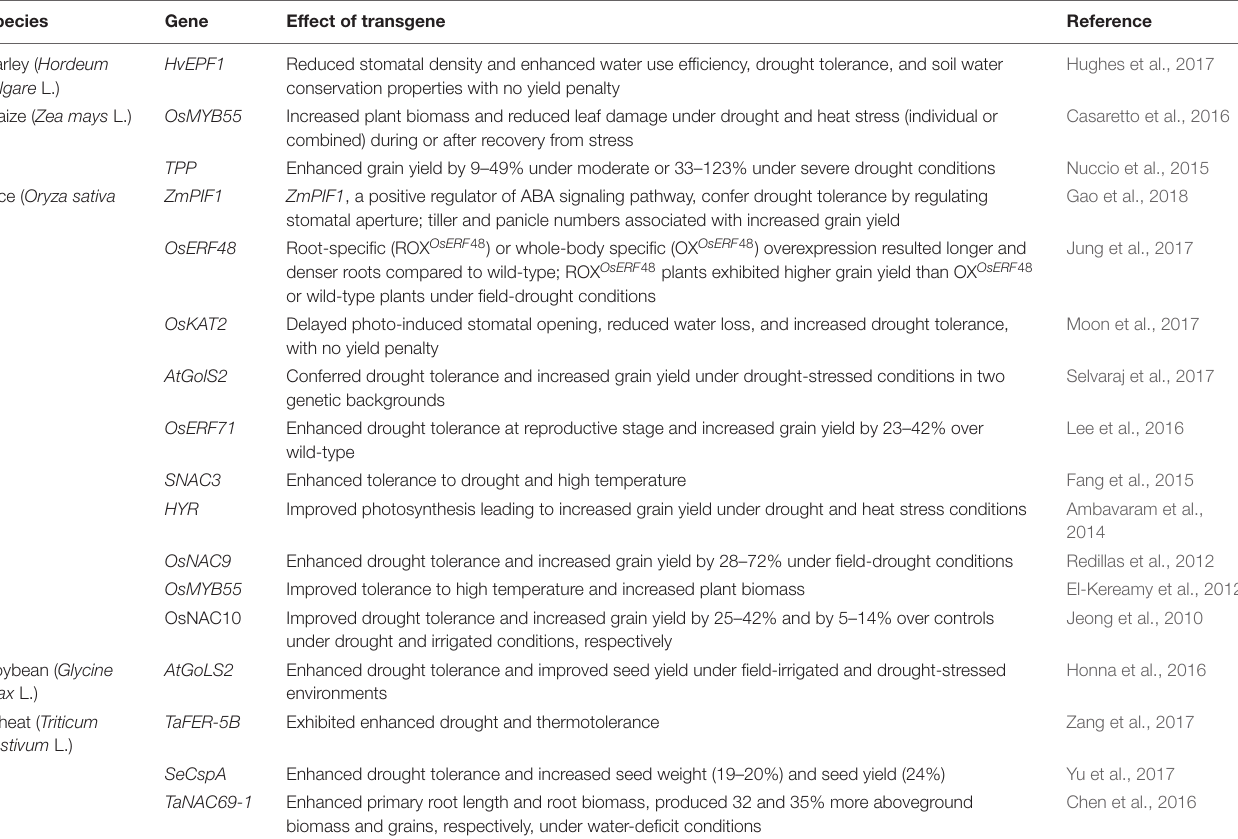
TABLE 4 | Overexpression of transgenes enhances drought adaptation and increases grain yields under field-drought environments in barley, maize, rice, soybean, and wheat from 2010–2018. Species Gene Effect of